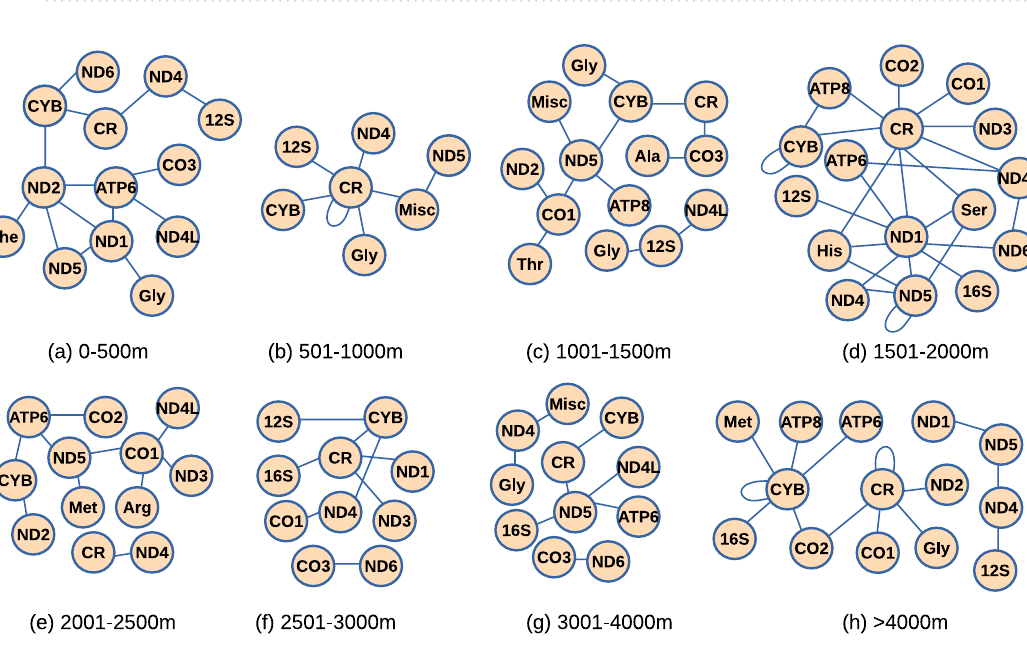
Figure 7. Gene–gene interaction pairs which showed deviation from random